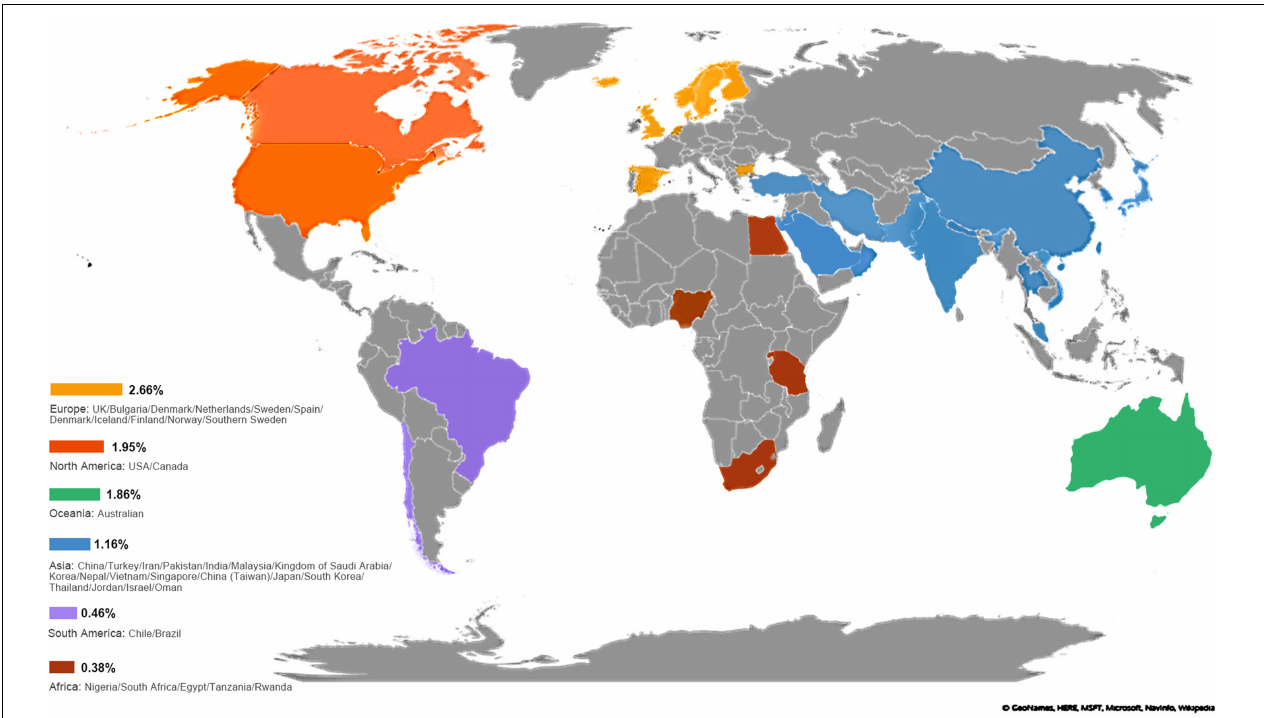
FIGURE 2 | Pooled prevalence of amblyopia based on countries. The reported prevalence values were pooled for each country. A darker shade of blue indicates higher prevalence. No data were available for the countries in